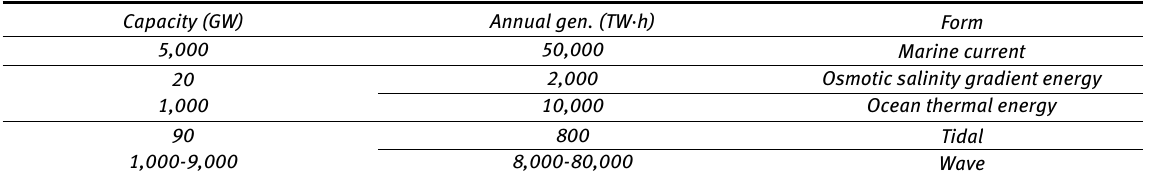
Table 1: Theoretical global ocean energy resources